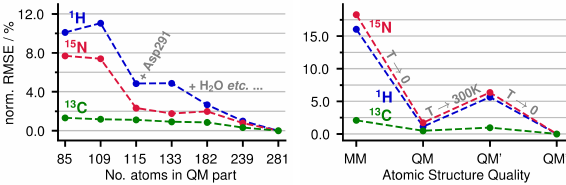
underlying molecular structures determined by either the level of theory (MM/QM) or the simulated temperature; the relative error of calculated shieldings drops from over 15% to less than 2% after direct annealing (i.e., without further equilibration) of the FFMD snapshot. Interestingly, thermal fluctuations let the error grow again above 5%. The atom types fluctuate differently with 1 H and 15 N being most susceptible. This corresponds to their chemical exposure to the protein environment.